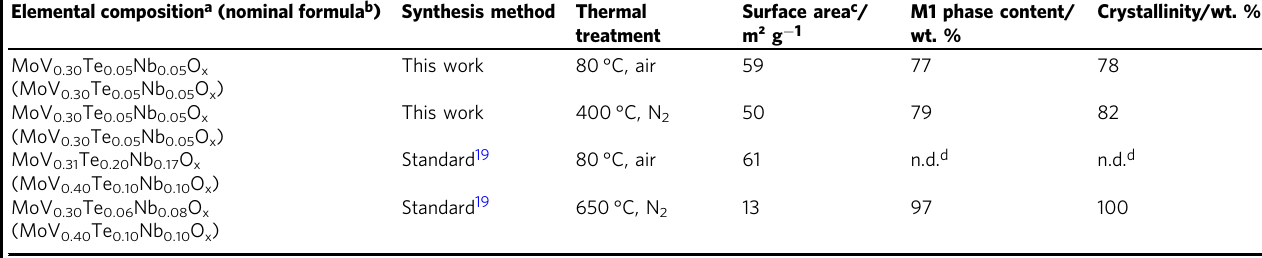
a Elemental analysis by inductively coupled plasma optical emission spectrometry (ICP-OES) b Stoichiometry of metals subjected to hydrothermal synthesis c Calculated according to Brunnauer-Emmett-Teller (BET) method. Samples were degasi fi ed at 250°C prior N 2 isotherm d Diffractogramshowsonlyasinglebroadre fl ectionaround2 Θ = 21.4°matchingthe{001}-planere fl ectionsofe.g.,M1,M2,andM 5 O 14 phases.Rietveldre fi nementofthediffractogramwasnotpossible due to missing long-range order in the sample